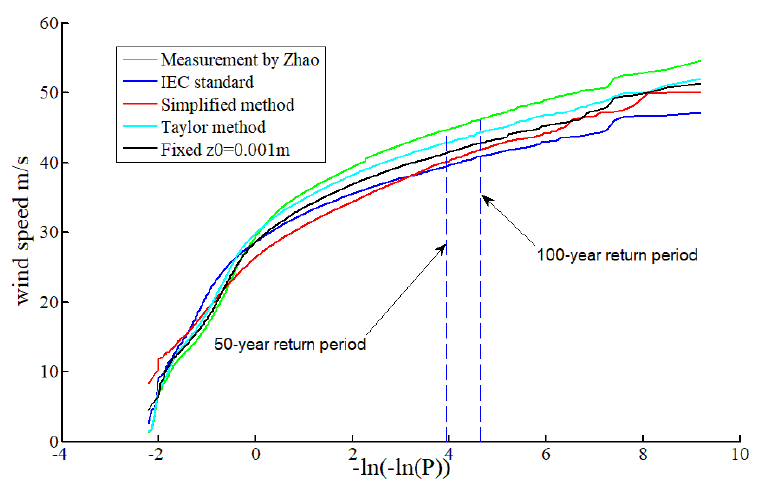
Figure 8. The comparison of the fitting distribution of EWS value with z 0 calculated by different methods. Table 4. Comparison of EWS with 50-year recurrence predicted by two methods for six OWF.